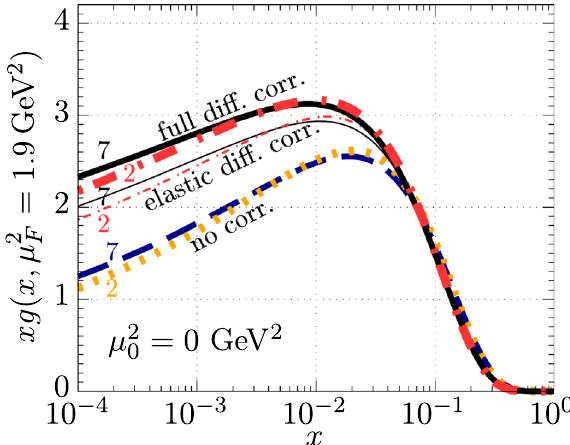
= 1 . 9GeV 2 . We show three pairs Fig. 4 Gluon distributions at μ 2 F of curves. In each pair the gluons differ according to whether the fit included DIS data with Q 2 > 2 or 7 GeV 2 . The lower pair of curves (marked no correction) are the conventional gluons. If we account for the full diffraction corrections then we obtain at low x noticeably larger gluons (the upper pair of curves). Finally the pair of thin curves cor- respond to the case where only the ‘elastic’ dDIS data are used as a correction (that is data with the proton being left